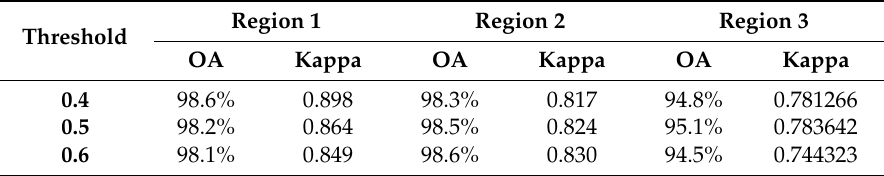
Table 5. The overall accuracy and kappa coefficient of the three regions under different